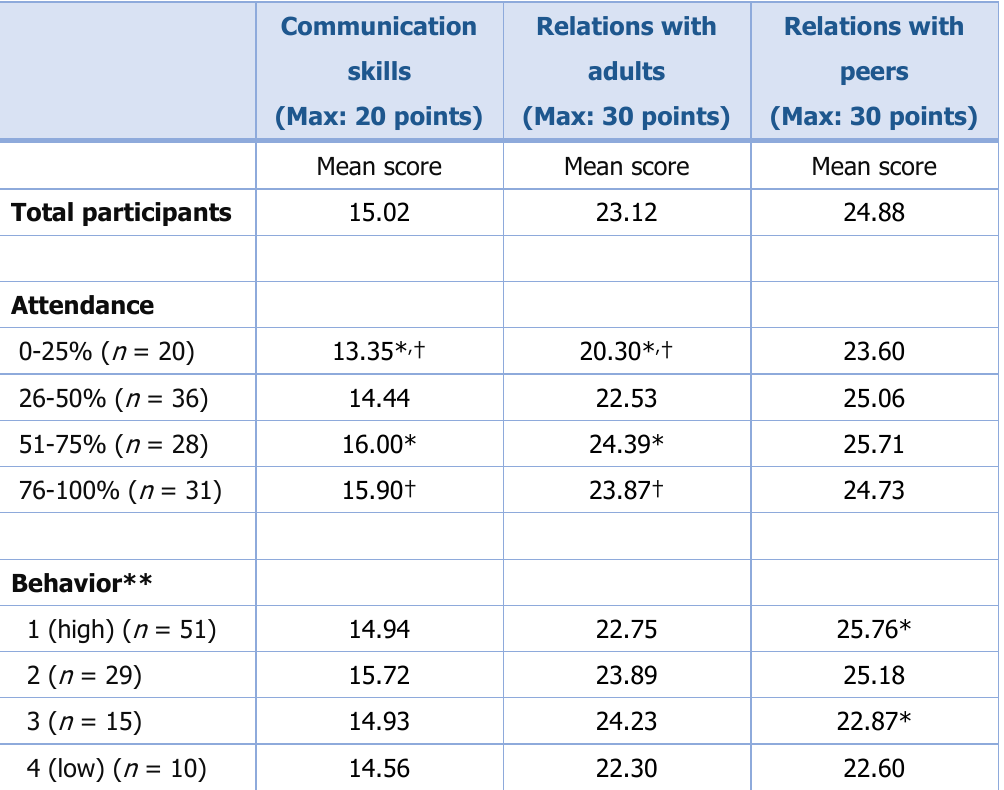
Table 3. Outcome Behavior Scales